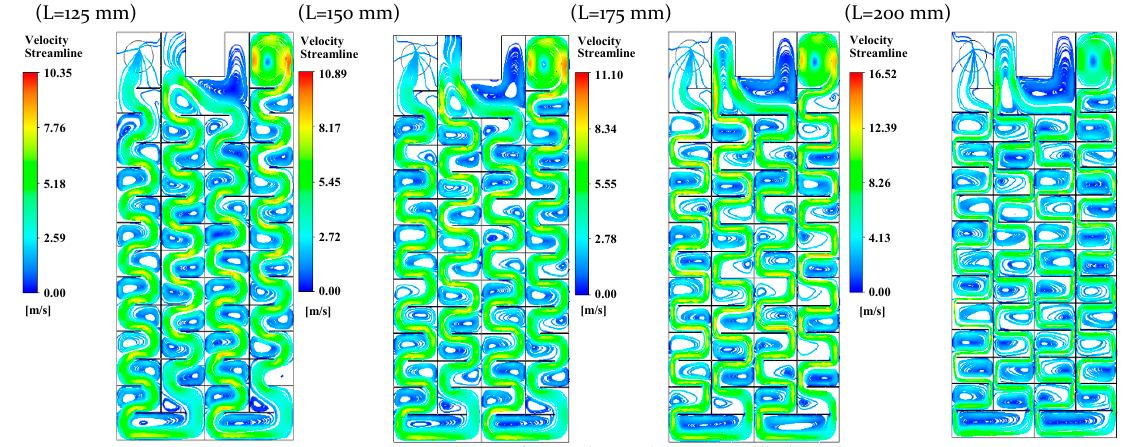
Figure 7. Streamlines of PVT depending on ba ffl e length. Table 5. Ba ffl e length sensitivity numerical